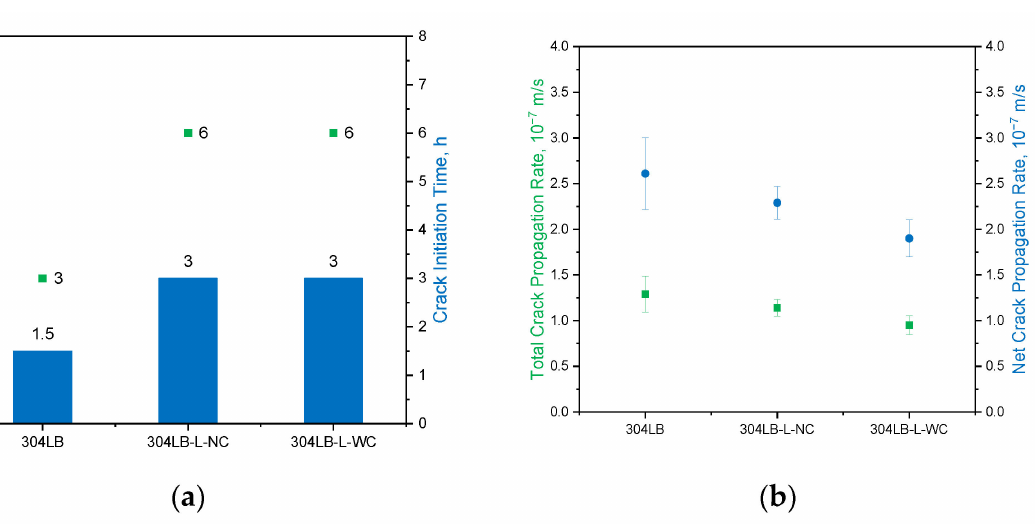
Figure 2. Effect of laser shock peening on the crack times of 304LB by U − bend SCC test at 155 ◦ C, 42% MgCl 2 : ( a ) total crack time; ( b ) crack propagation